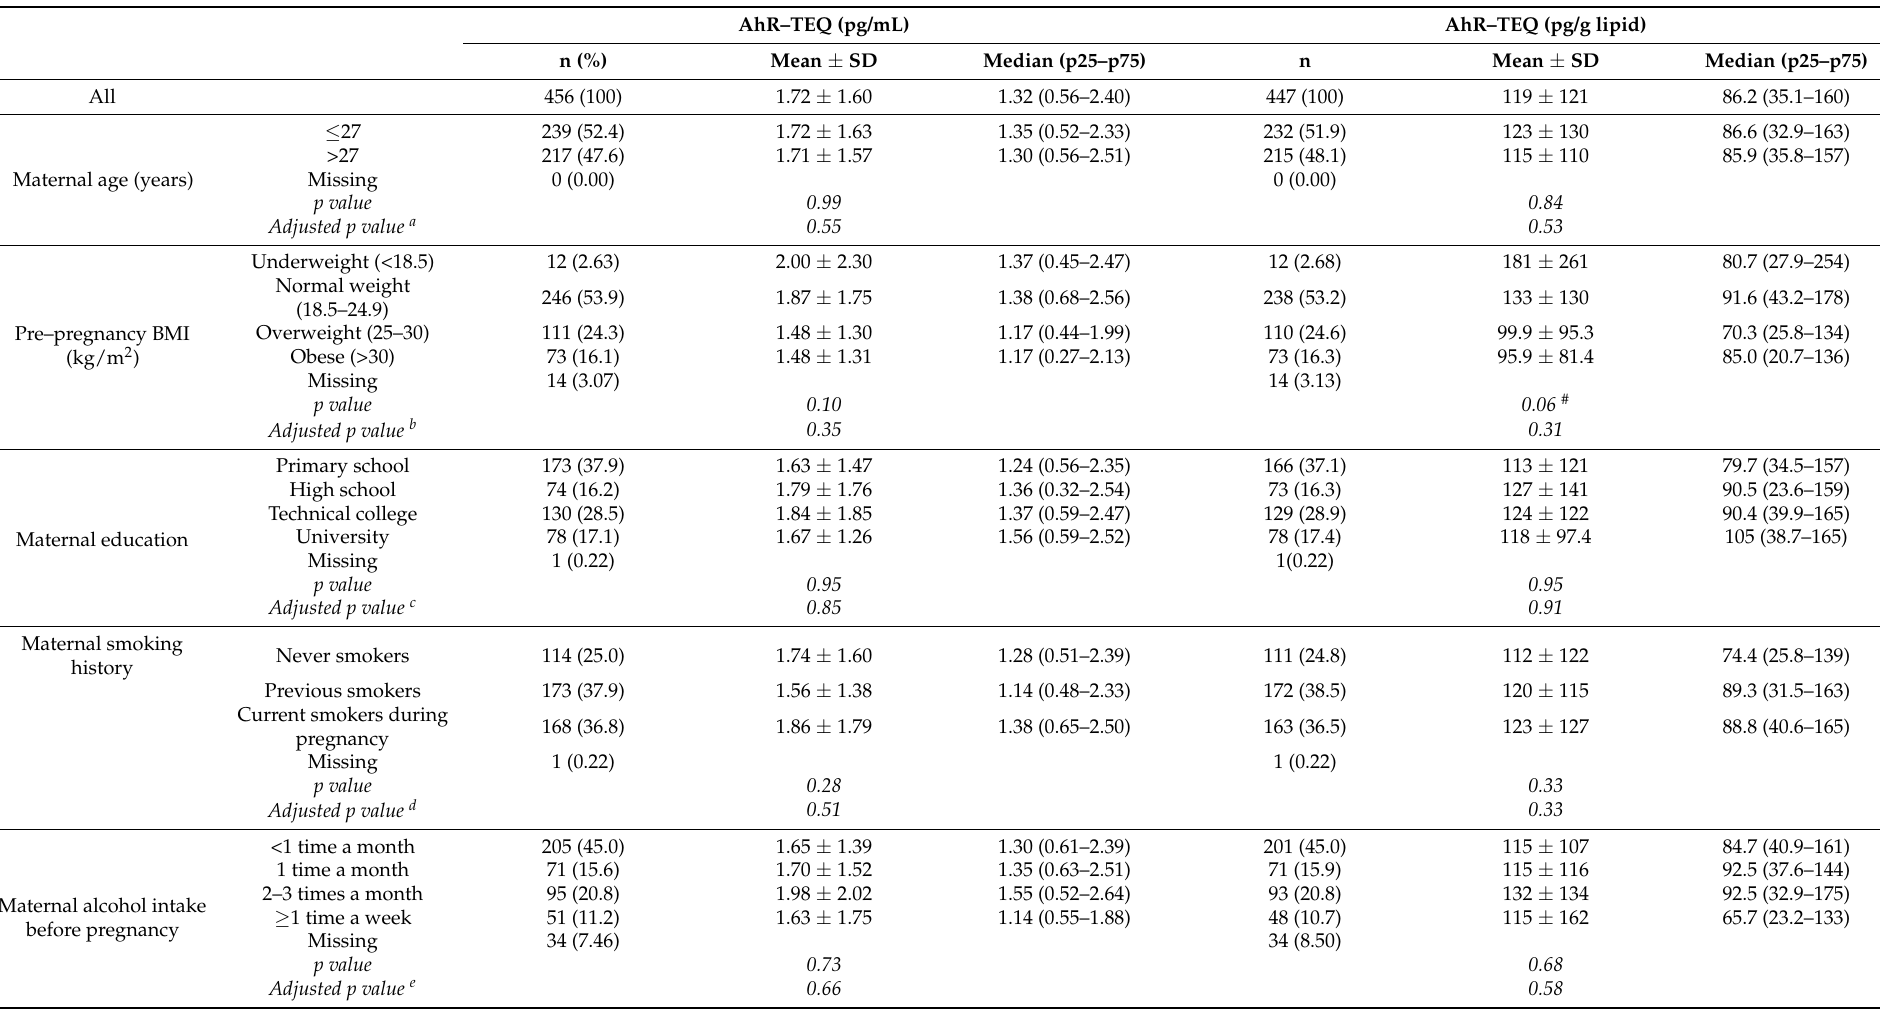
Table 2. ACCEPT pregnan women characteristics and maternal serum